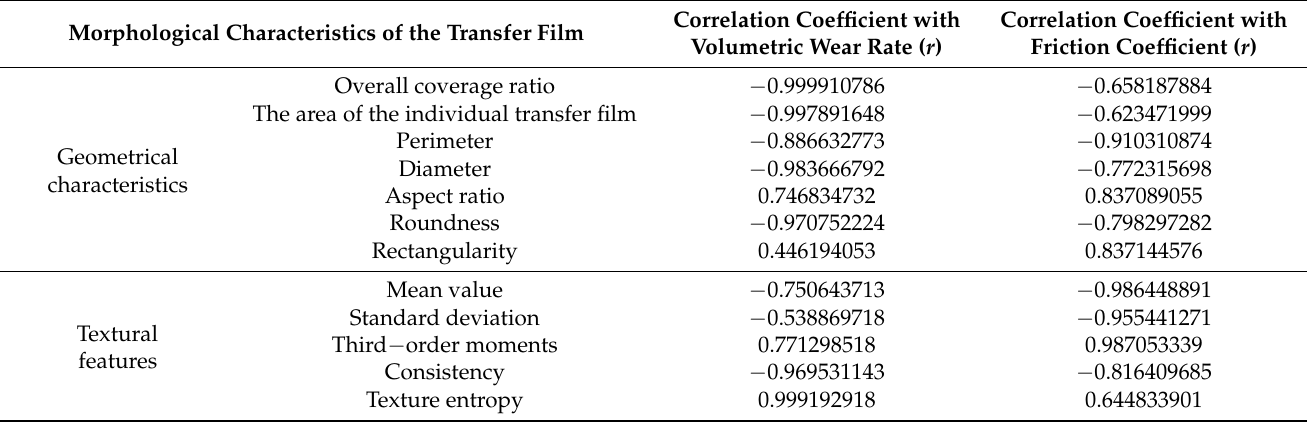
Table 1. Correlation of transfer film morphological characteristics parameters with tribological properties (coefficient of friction and volumetric wear